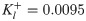
Visualization of the leading-edge vortex during the 6th wingbeat for the simplified kinematics cases, IGE.Left column (a-e) shows the dimensionless pressure distribution over the surface of the model and over a semisphere of radius 0.9R around the body point of reference. Middle column (f-j) shows the pressure iso-contours for two different takeoffs: Kl+=0.0095 N/m and 0.0430 N/m. Right column (k-o) compares iso-contours of the dimensionless vorticity magnitude for the same two takeoffs. Time instants are t = 24.73, 25.68, 26.63, 27.58 and 28.53 ms (tf = 5.2, 5.4 5.6, 5.8 and 6, where f is the wingbeat frequency).